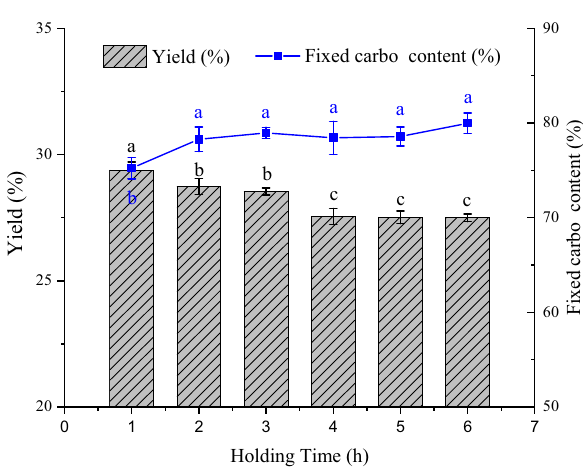
Figure 2: E ff ect of holding time on yield and fi xed carbon content of biochar. Bar plots and points are indicated as mean of three repli - cates and vertical bar indicates ± SE. Di ff erent letters indicate sig - ni fi cant di ff erences between treatments at P <